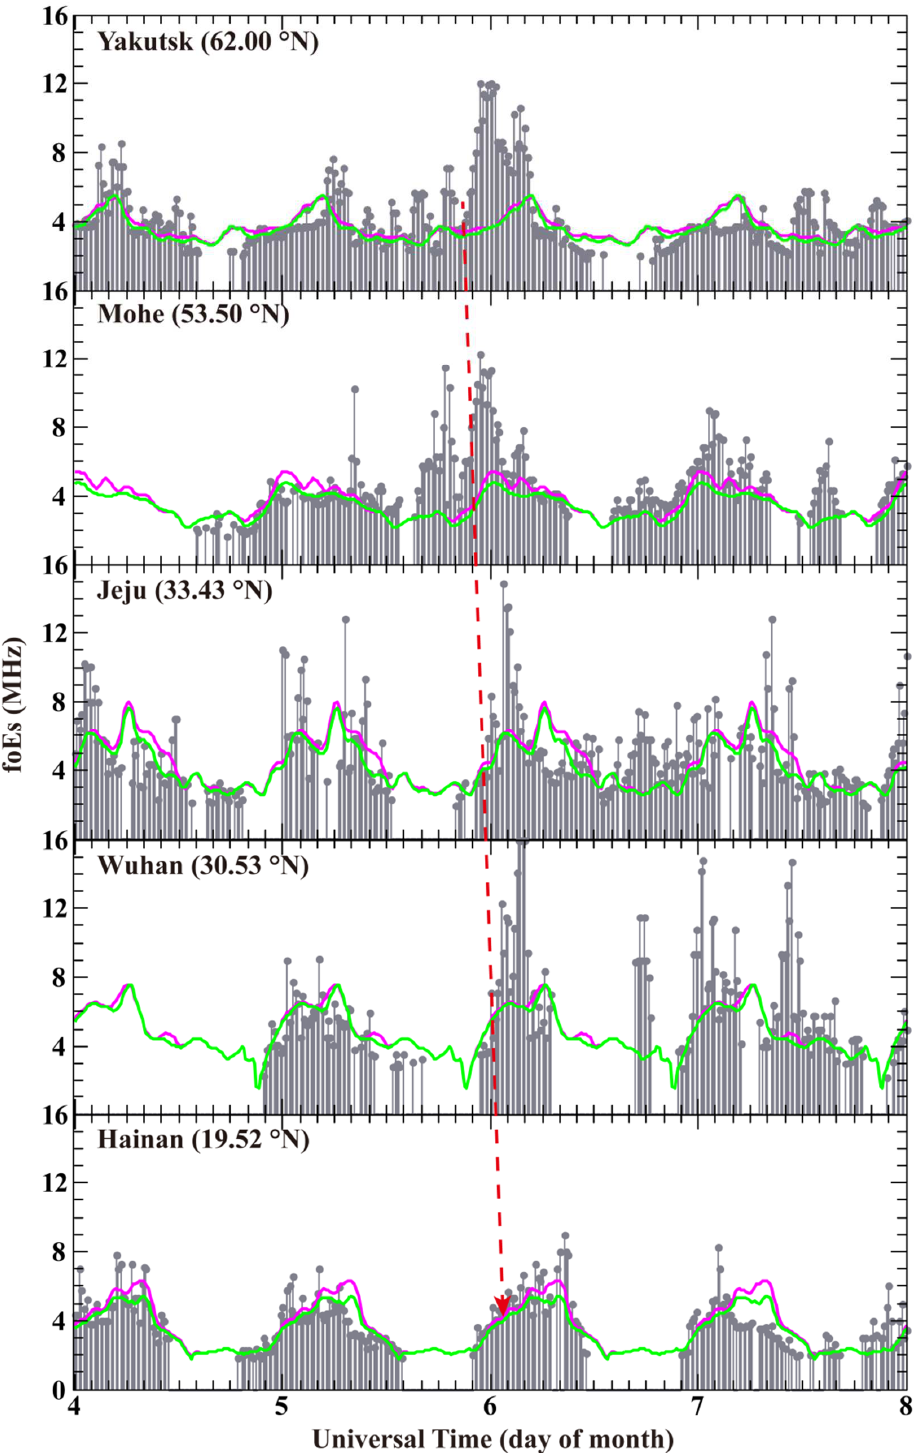
Figure 4. Observation of foEs during magnetic storm between 4 and 8 July 2013. The subplots are aligned from top to bottom according to latitudes. The red and green curves represent mean and median value of foEs, which are obtained from five days before storm (from 1 to 5 July 2013). The red-dashed line with arrow indicates the sequentially enhancement onset of the foEs.